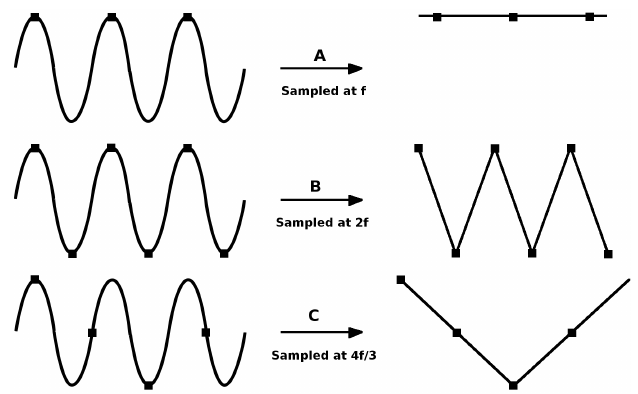
Figure 2. Effects of various sampling rates while sampling a signal